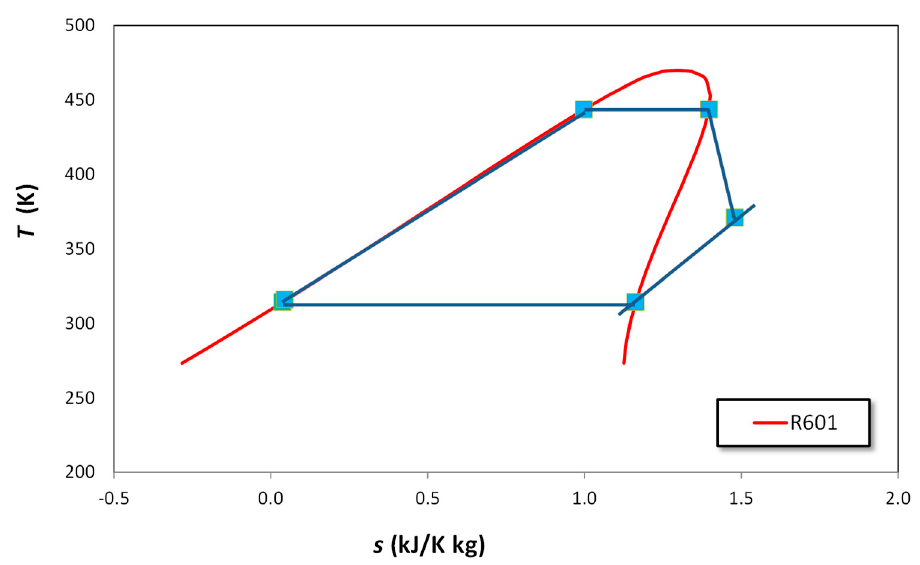
Figure 7. Actual Rankine cycle in the temperature-entropy diagram.